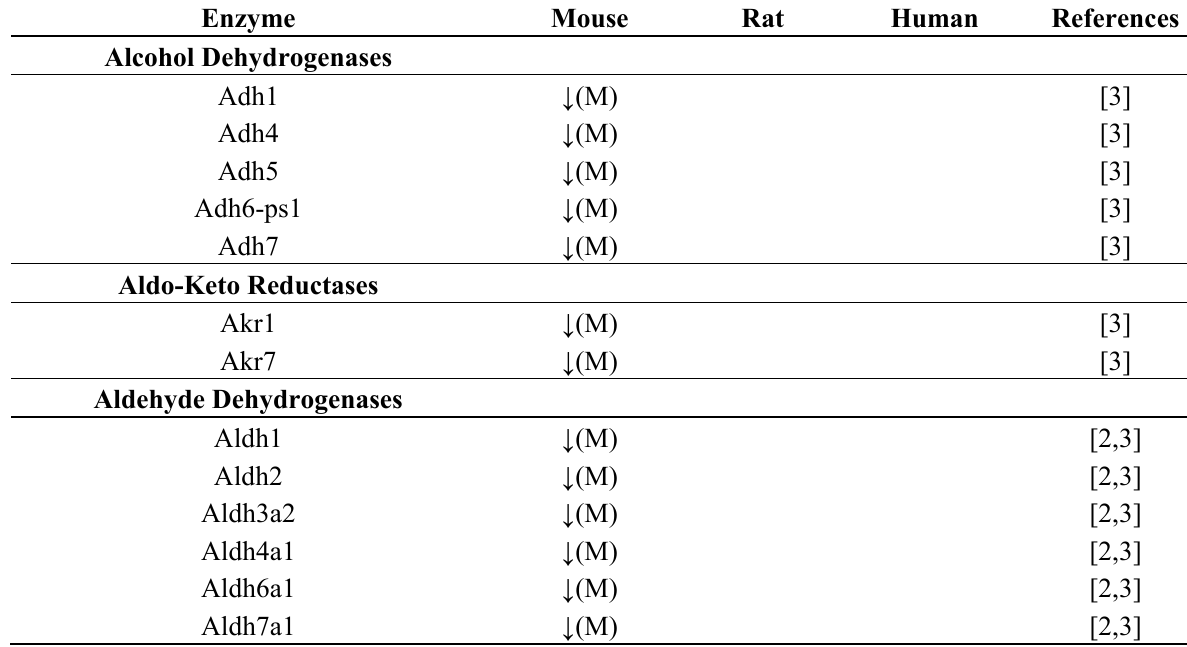
Enzyme Mouse Rat